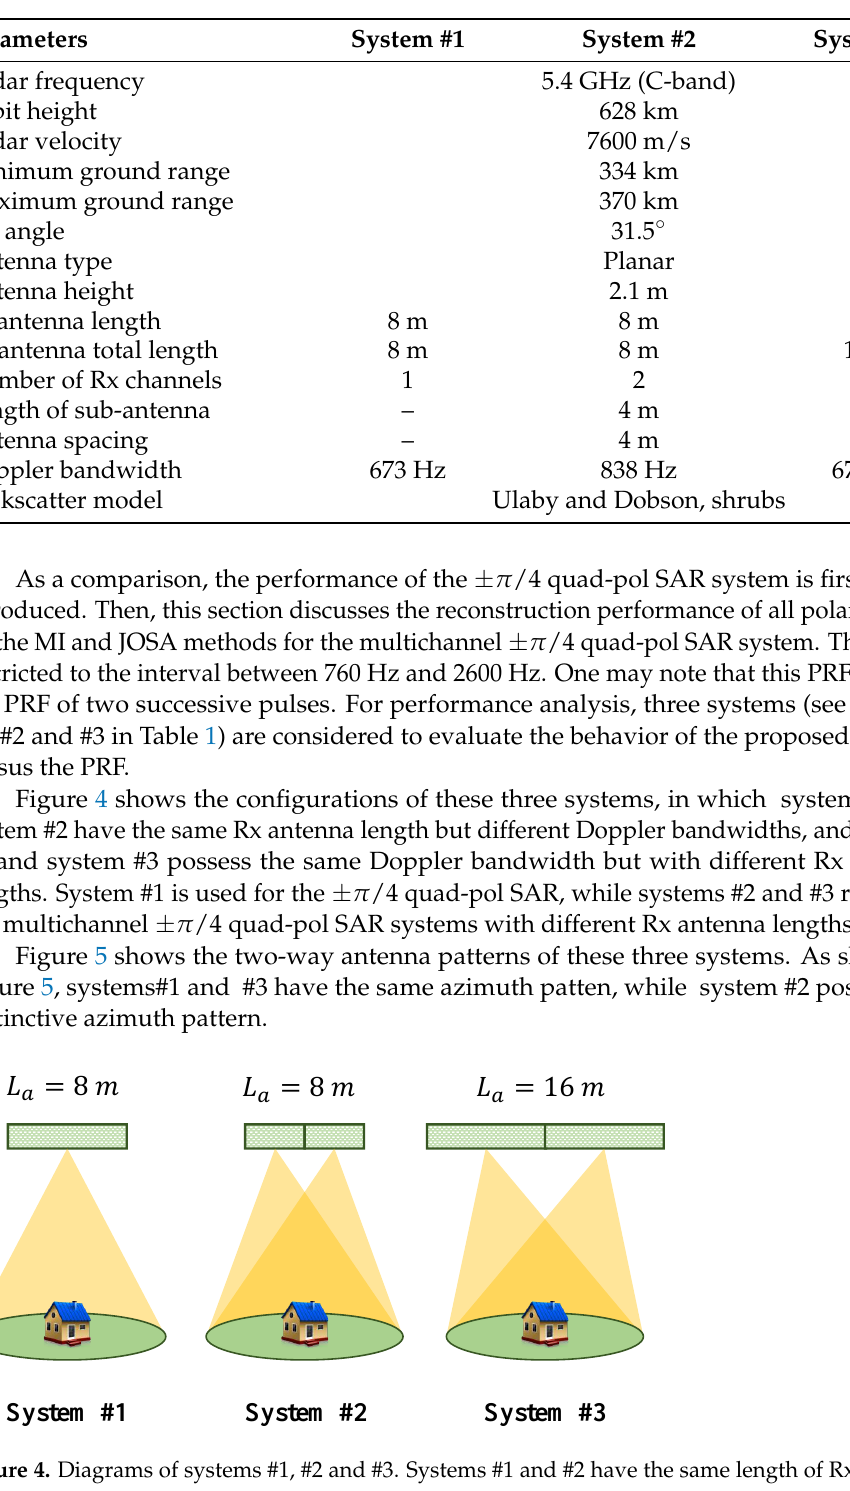
Table 1. System Parameters.